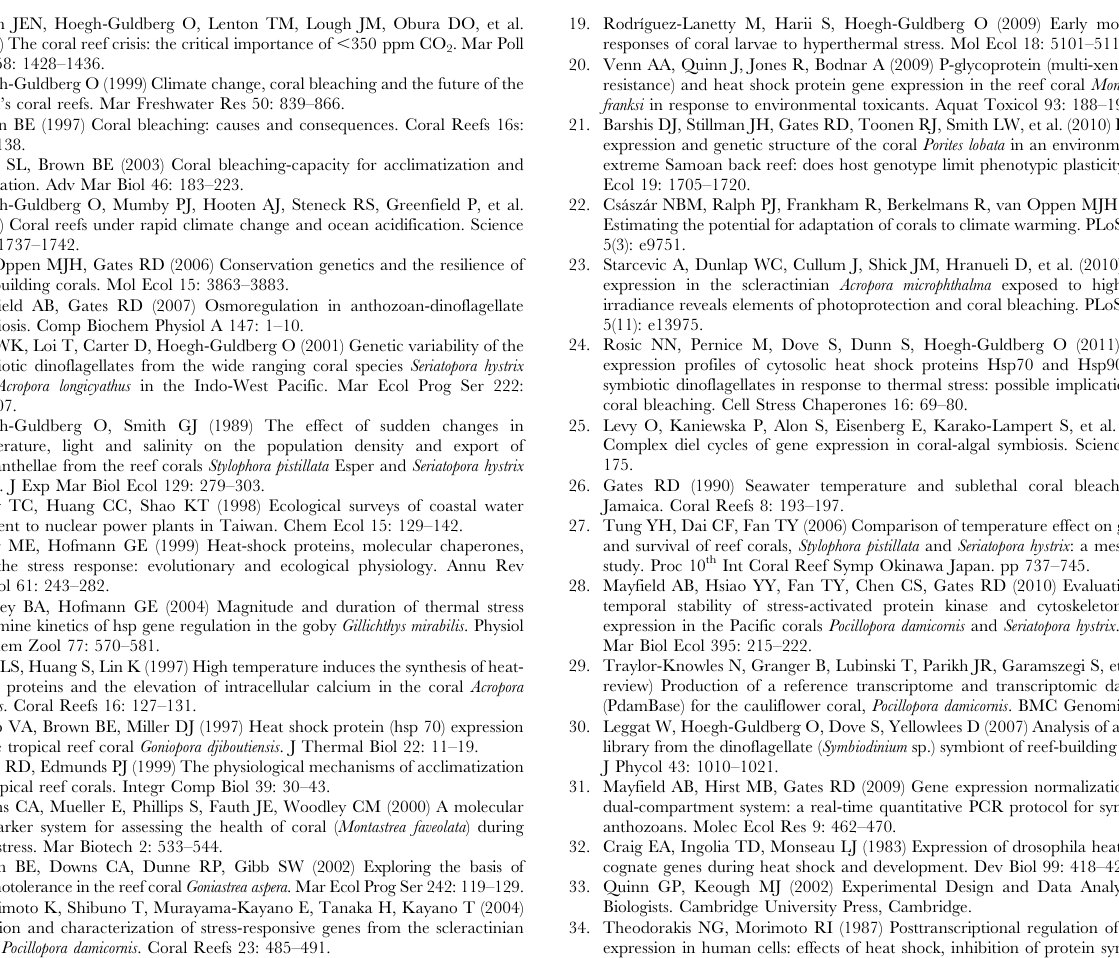
Table S2 Real-time quantitative PCR primers designed for use with SYBR H green I chemistry with whole holobiont total RNA extracts from Seriatopora hystrix . Assays in which it was necessary to dilute the cDNA 10-fold